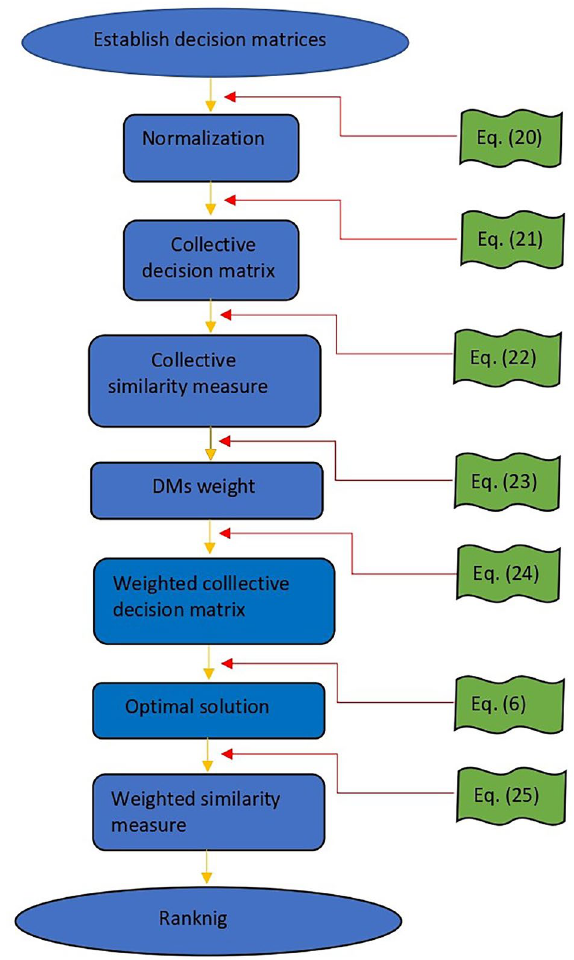
Figure 1. Flow chart of the proposed